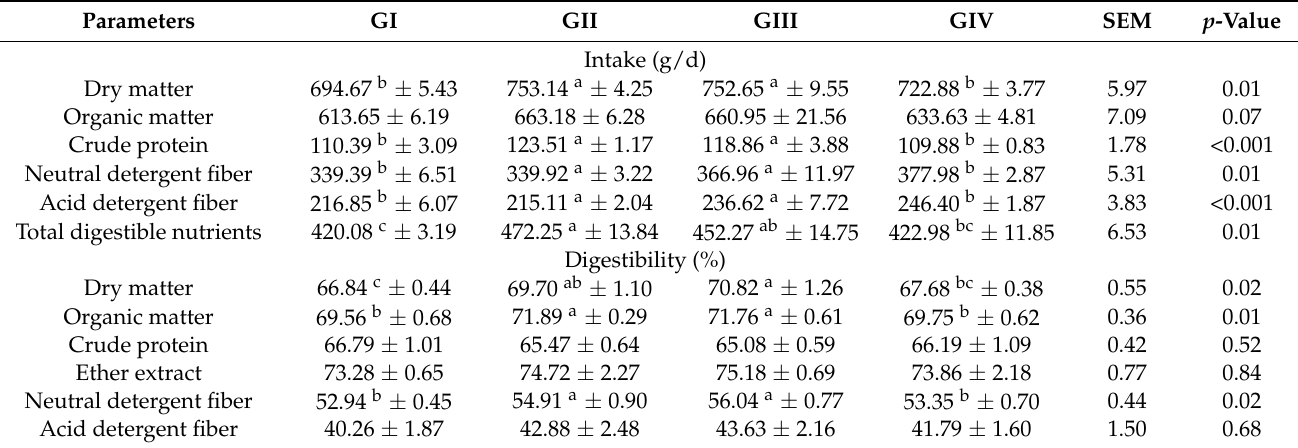
Table 3. Nutrient intake and digestibility in different groups: GI (control), GII (60R:40C with 10% of concentrate replaced with ML), GIII (70R:30C and 20% replacement of concentrate with ML), and GIV (80R:20C and 20% replacement of concentrate with ML).